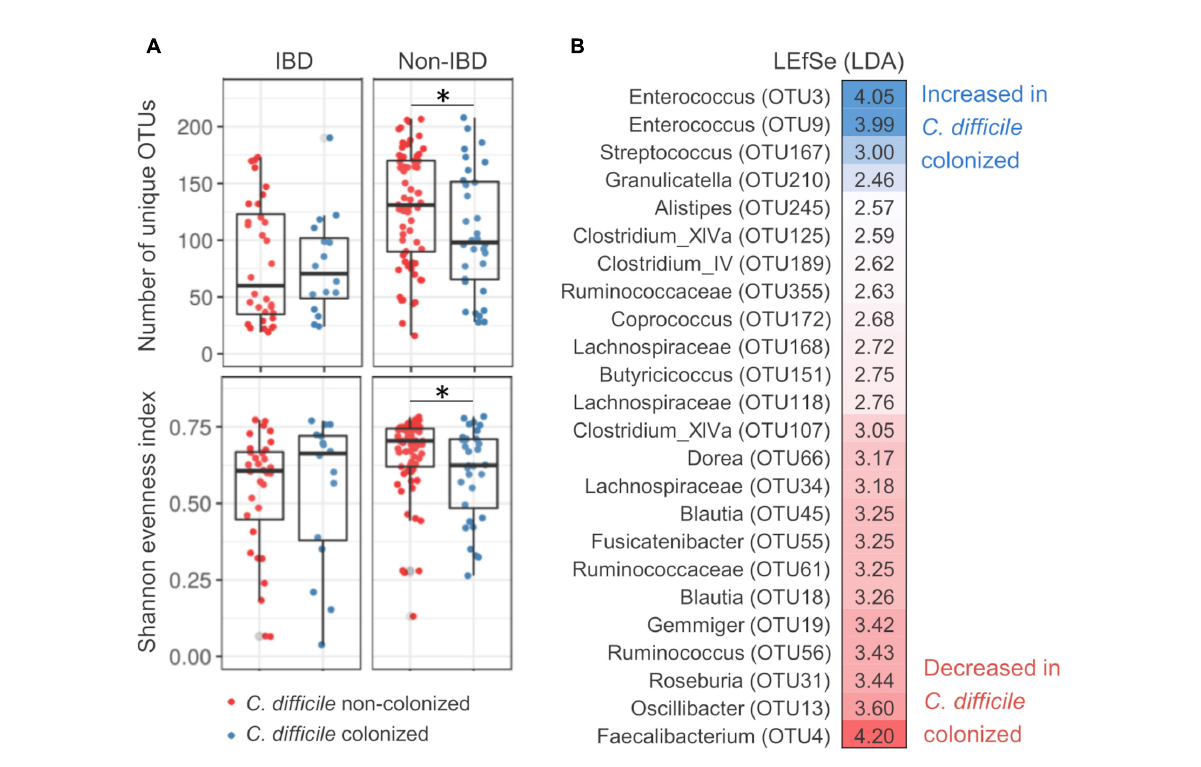
FIGURE1 Bacterial community characteristics of Clostridioides difficile- colonized patients with regard to inflammatory bowel disease status. (A) Clostridioides difficile colonization-associated differences in bacterial community richness [number of unique operational taxonomic units (OTUs), top] and evenness (Shannon evenness, bottom) for inflammatory bowel disease (IBD) and non-IBD patients. (B) OTUs that were differentially represented between C. difficile- colonized and non-colonized patients, as obtained by LEfSe population analysis. Population analysis was performed only on non-IBD patients for which beta-diversity analysis showed significant differentiation between C. difficile- colonized and non-colonized. *Denotes significance with p value between 0.05 and